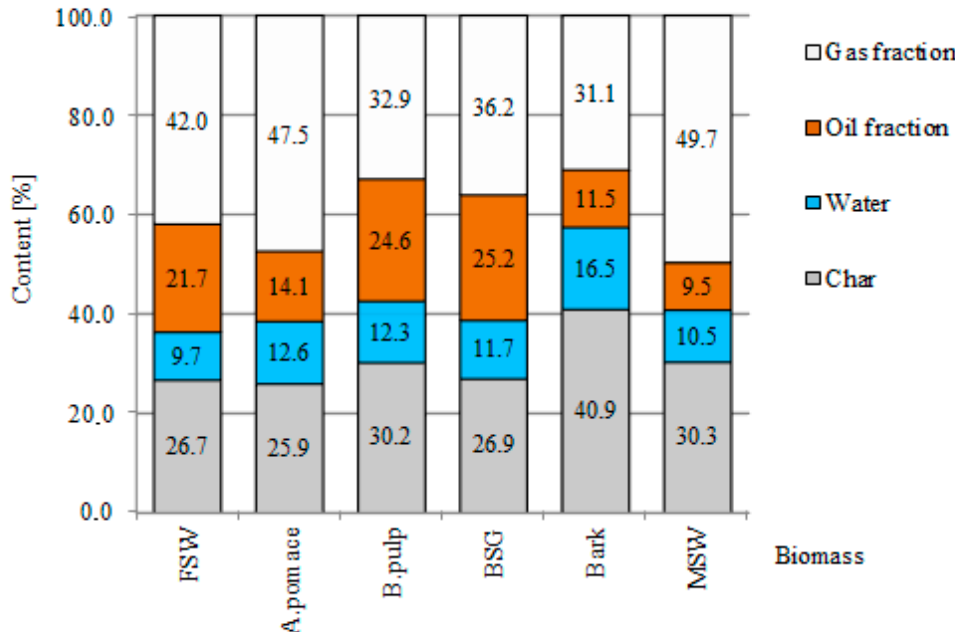
Figure 2. Solid, liquid and gaseous product distribution (wt.%), expressed as average values, obtained with carbonization (850 °C).